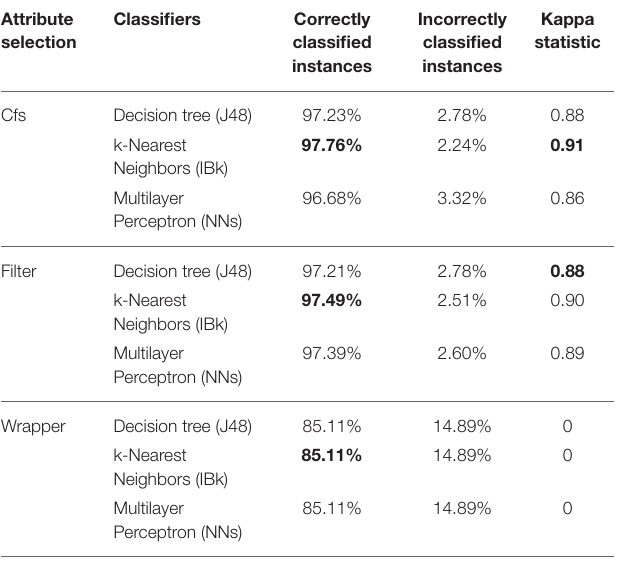
TABLE 4 | Classifiers accuracy for the FLDA classification method of each attribute selection method.